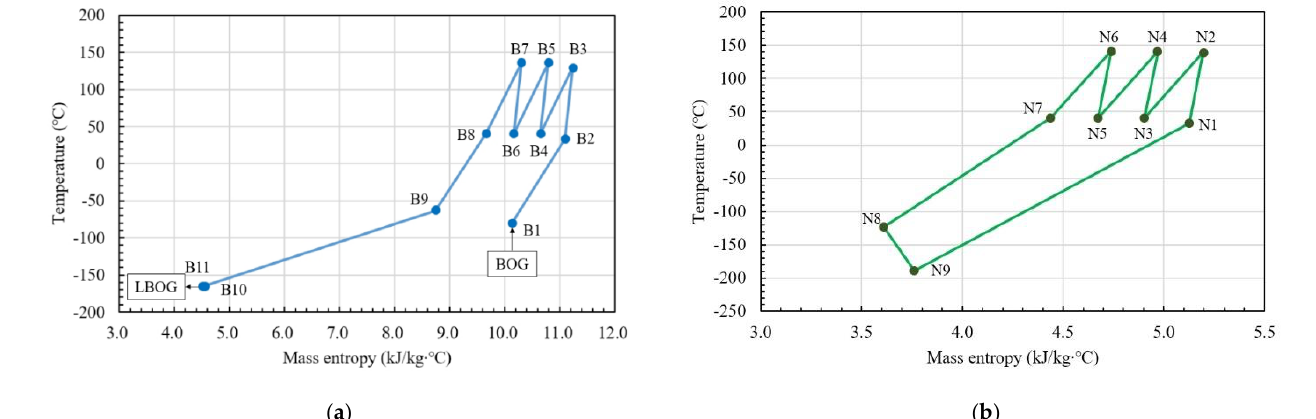
Figure 6. T-S diagram of the BOG re-liquefaction system for a base case: ( a ) BOG, ( b ) N 2 .